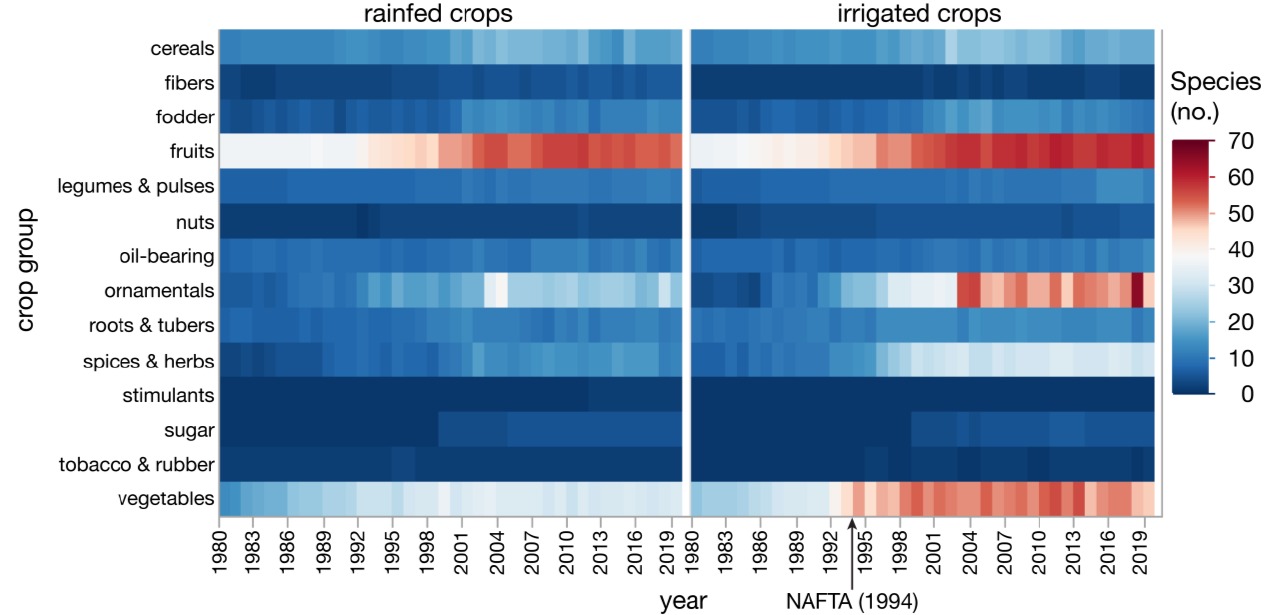
Figure 2. Number of rainfed and irrigated crop species (richness) for each crop group from 1980 to 2019. The arrow marks implementation of the North American Free Trade Agreement (NAFTA) in 1994.